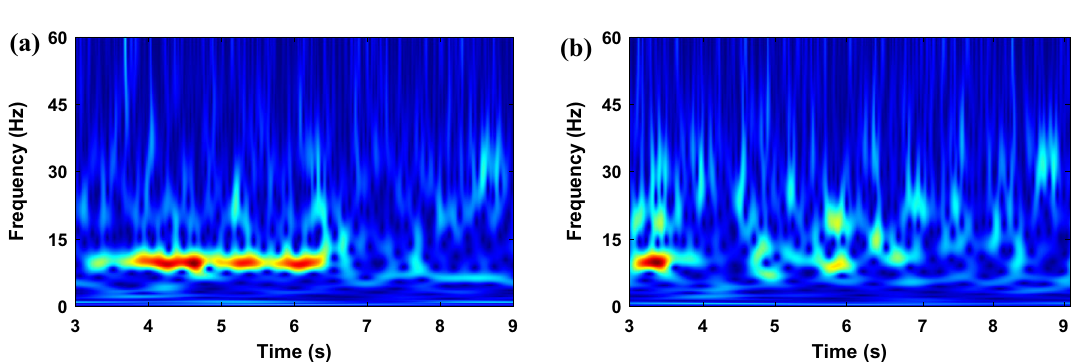
Figure 5. Absolute of Stockwell TFM corresponding to the right-hand MI signal from dataset II–III. ( a ) C3 channel, and ( b ) C4 channel.